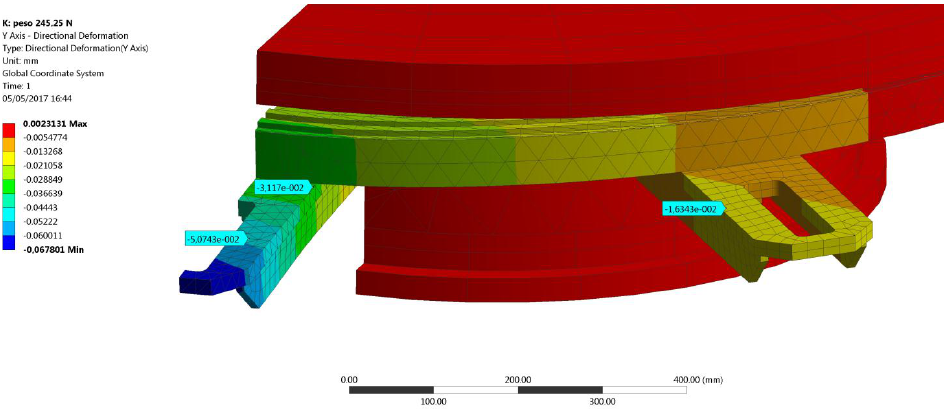
Figure 7. FE displacements (scale factor ×1000).